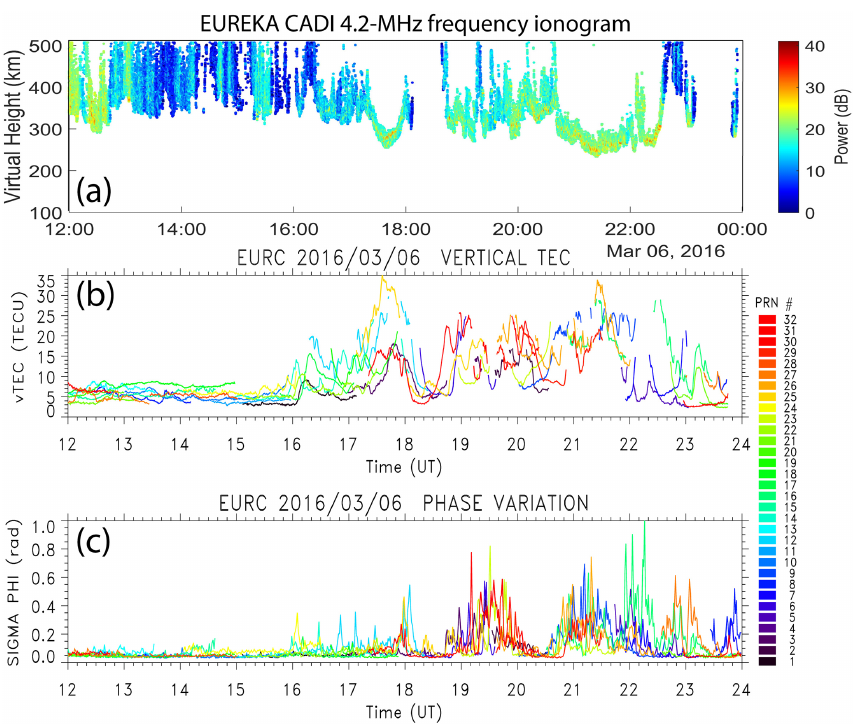
Figure 15. Panel (a) displays the fixed 4.2MHz frequency ionogram, the GPS (b) vTec, and (c) phase variation observed from Eureka on 6 March